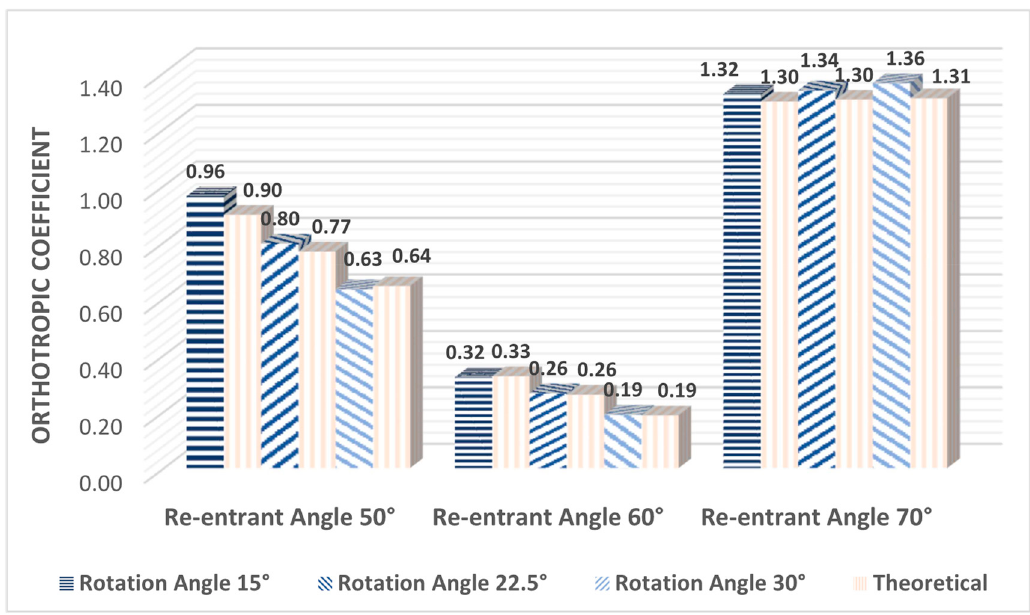
Figure 12. Mechanical orthotropy coefficients for all samples constructed with different values for the re-entrant angle θ = { 50 ◦ ;60 ◦ ;70 ◦ } and different values for the angle of rotation ∅